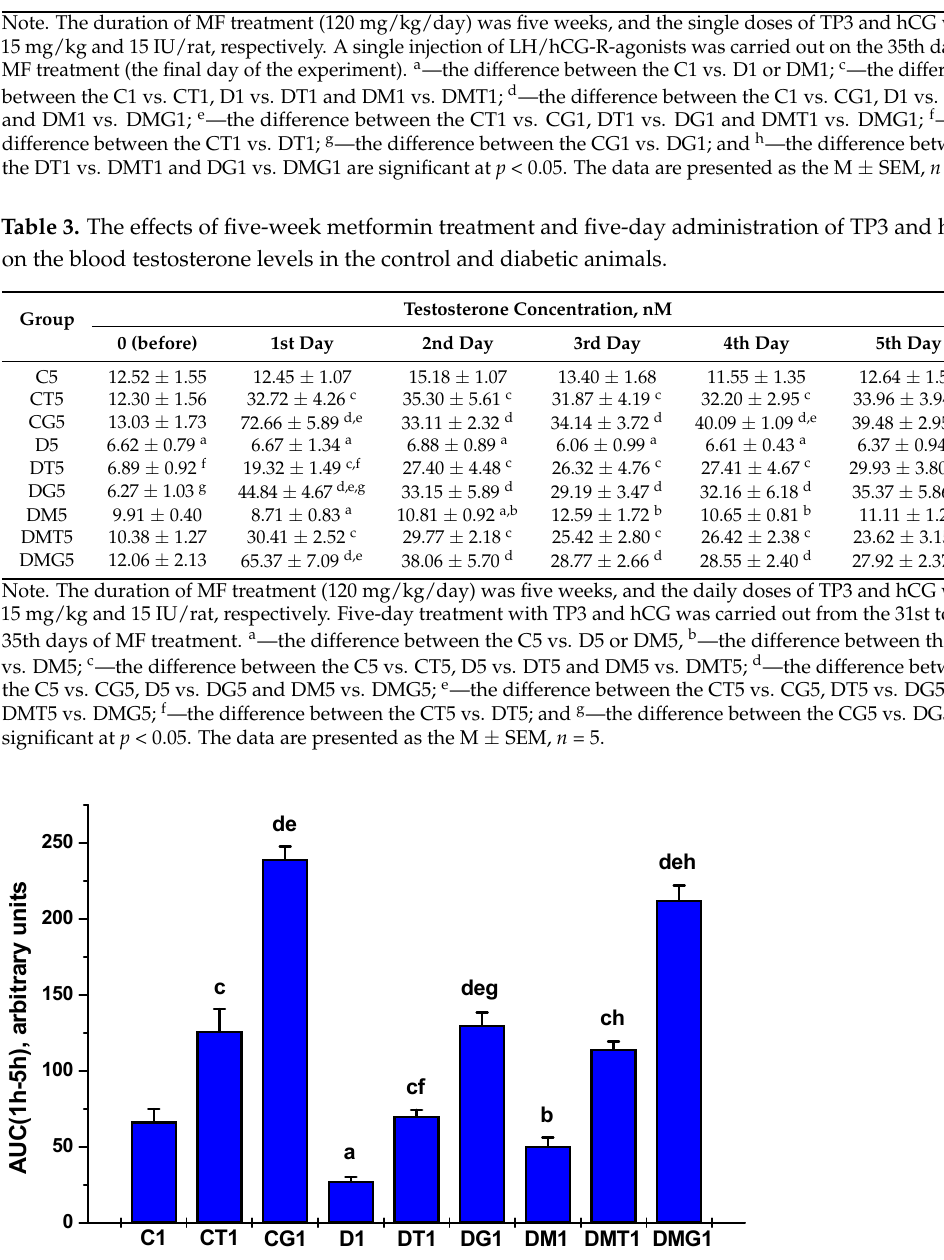
Figure 1. The AUC 1h-5h values for the curves “testosterone concentration (nM) vs. time (hours)” in Table 3. and hCG. The AUC 1h-5h values are given for the curves “testosterone concentration (nM) vs. time (hours)”, where 1h–5h represent the intervals from the first to fifth hours of treatment. The duration of MF treatment (120 mg/kg/day) was five weeks, and the single doses of TP3 and hCG were 15 mg/kg and 15 IU/rat, respectively. A single injection of LH/hCG-R-agonists was carried out on the 35th day of MF treatment (the final day of the experiment). a —the difference between the C1 vs. D1; b —the difference between the D1 vs. DM1; c —the difference between the C1 vs. CT1, D1 vs. DT1 and DM1 vs. DMT1; d —the difference between the C1 vs. CG1, D1 vs. DG1 and DM1 vs. DMG1; e —the difference between the CT1 vs. CG1, DT1 vs. DG1 and DMT1 vs. DMG1; f —the difference between the CT1 vs. DT1; g —the difference between the CG1 vs. DG1 or DMG1; and h —the differ- ence between the DT1 vs. DMT1 and DG1 vs. DMG1 are significant at p < 0.05. The data are pre- sented as the M ± SEM , n = 5. 04080120160